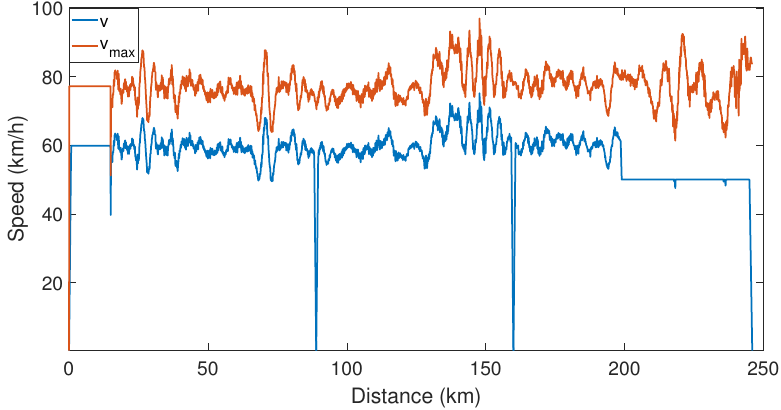
Figure 17. Speed profile of the route Chiriguaná – Santa Marta with S-594-2 locomotive. Using Algorithm 2 resulted in (cid:126) t , (cid:126) v , (cid:126) D is , (cid:126) α , and (cid:126) r C ; hence, at this point, it was